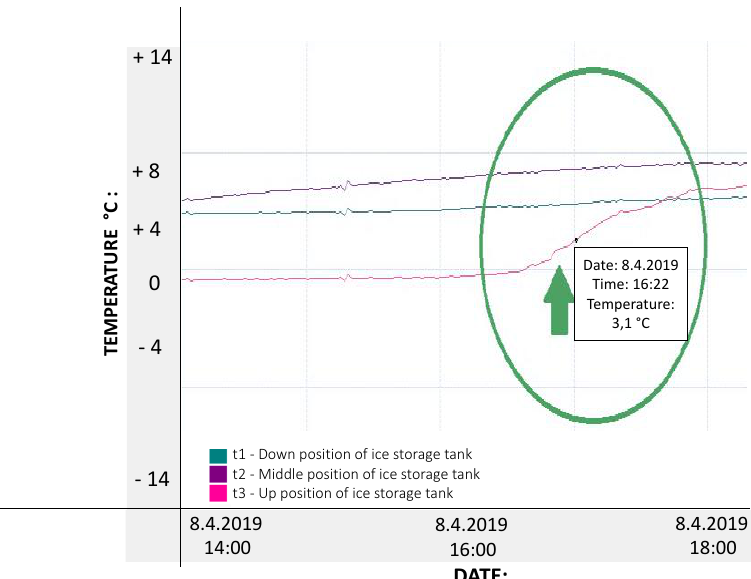
Figure 23. III. Phase—Melting ice t3.